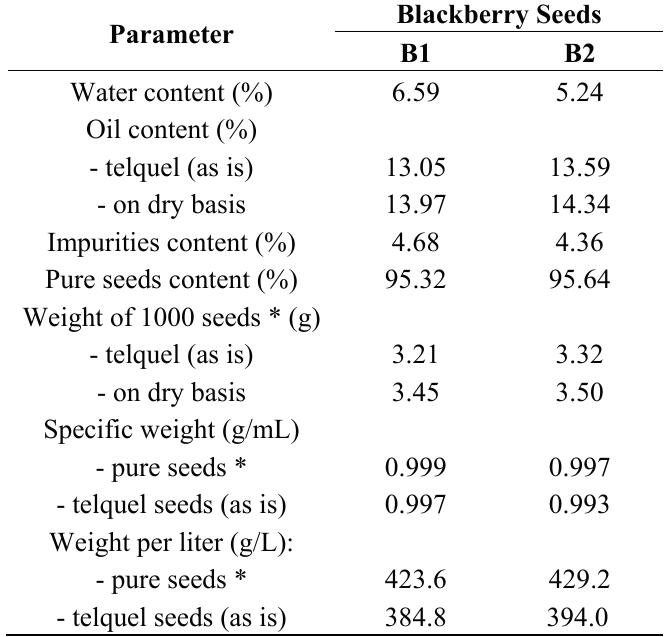
Table 3. Technological quality parameters of blackberry seeds grown in Serbia